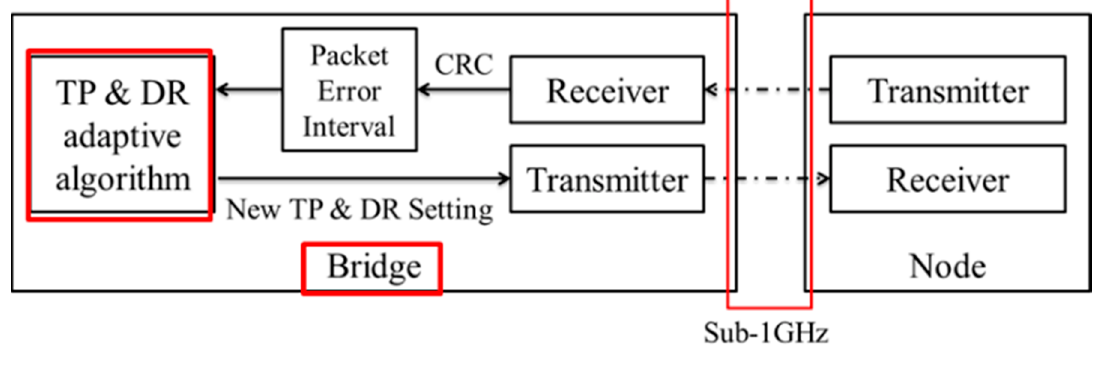
Figure 9. Control architecture between the bridge and sensor nodes.